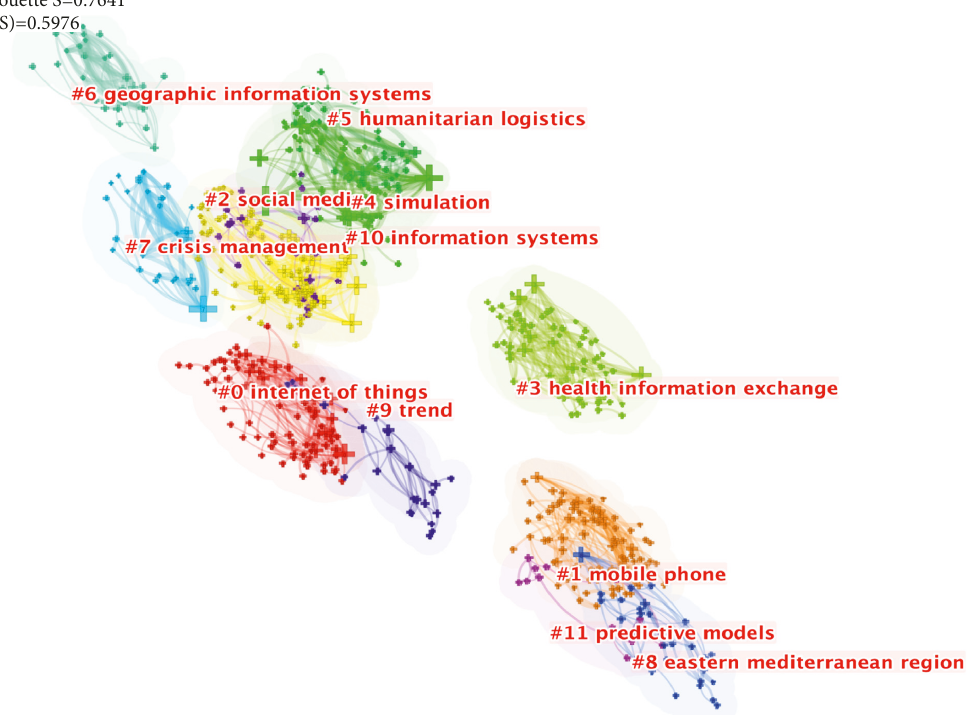
Figure 10: Co-word clustering map of international DEM